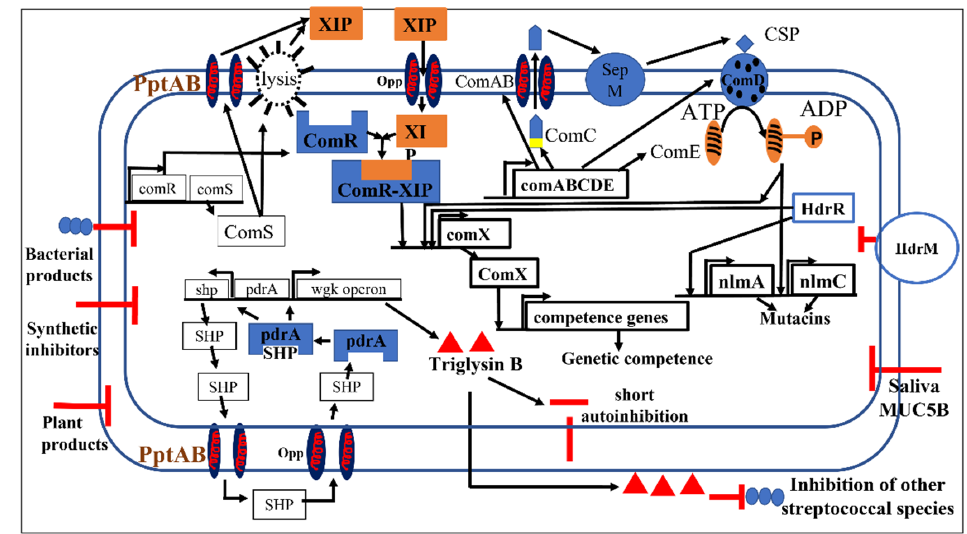
Figure 3. The CSP/ComABCDE, XIP-ComRS and PdrA-WGK pathways and their interaction, inhibition, and activation in S. mutans .